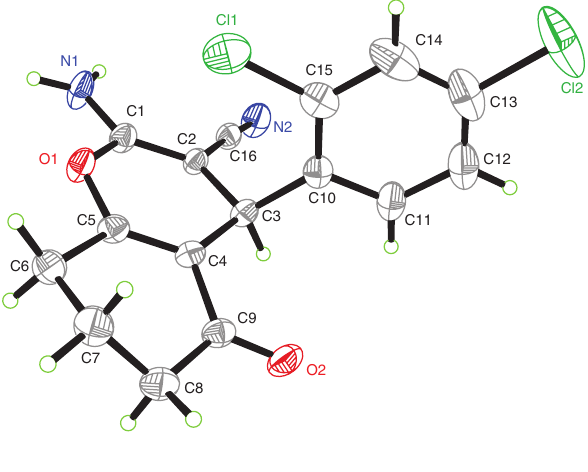
Table 1: Data collection and handling.